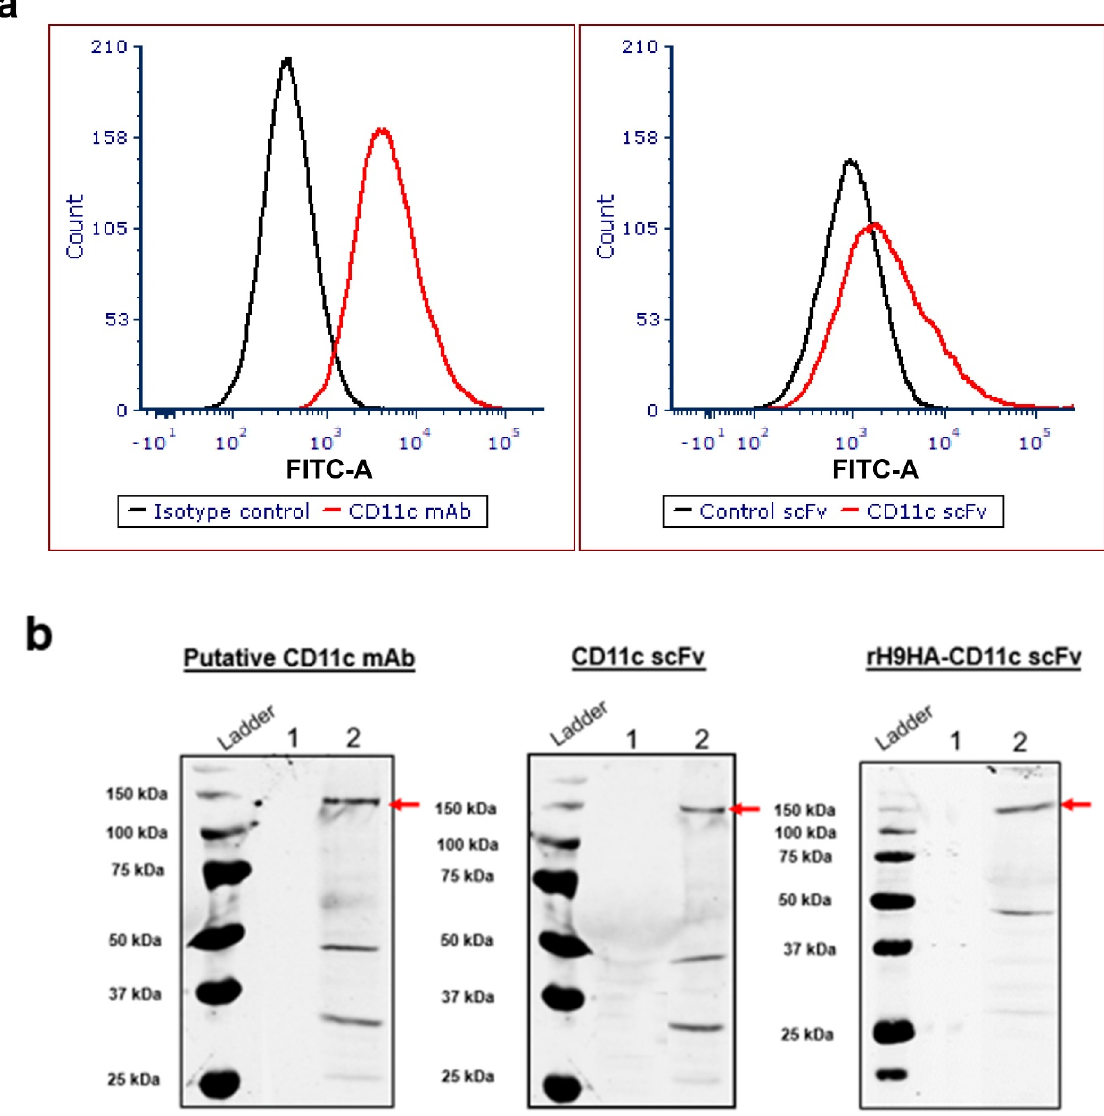
Figure 4. Characterisation of CD11c mAb, CD11c scFv, and rH9HA-CD11c scFv. ( a ) Staining of chicken splenocytes by putative CD11c mAb and CD11c scFv using flow cytometry. About 1 × 105 chicken splenocytes were stimulated with 200 ng/mL of LPS for 24 h. The splenocytes were centrifuged and incubated with 1 μ g/mL putative CD11c mAb for 20 min at 4 °C or 3 μ g/mL of CD11c scFv for 45 min at 4 °C. This was followed by incubation with secondary antibodies (FITC conjugated goat anti-mouse secondary antibody (1:200) if CD11c mAb was used or FITC conjugated anti V5 tag (1:100 dilution) if CD11c scFv was used) and incubated in dark for 30 min at 4 °C. The labelled splenocytes were fixed with 50 μ L of 1% PFA for 20 min in dark. The plates were read the next day using MACSQuant flow cytometer and analysed with FCS Express 6 software. ( b ) Detection of CD11c receptor protein from the chicken splenocyte extract by putative CD11c mAb, CD11c scFv, and rH9HA-CD11c scFv. In all cases, lane 1 represents Drosophila melanogaster S2 cell extract (control) and lane 2 represents chicken splenocyte extract (red arrow). The chicken splenocyte extract was run on 8–10% SDS-PAGE, blotted onto nitrocellulose membrane and immunodetected using either 1 µ g/mL of CD11c mAb or equimolar concentration of CD11c scFv and rH9HA-CD11c